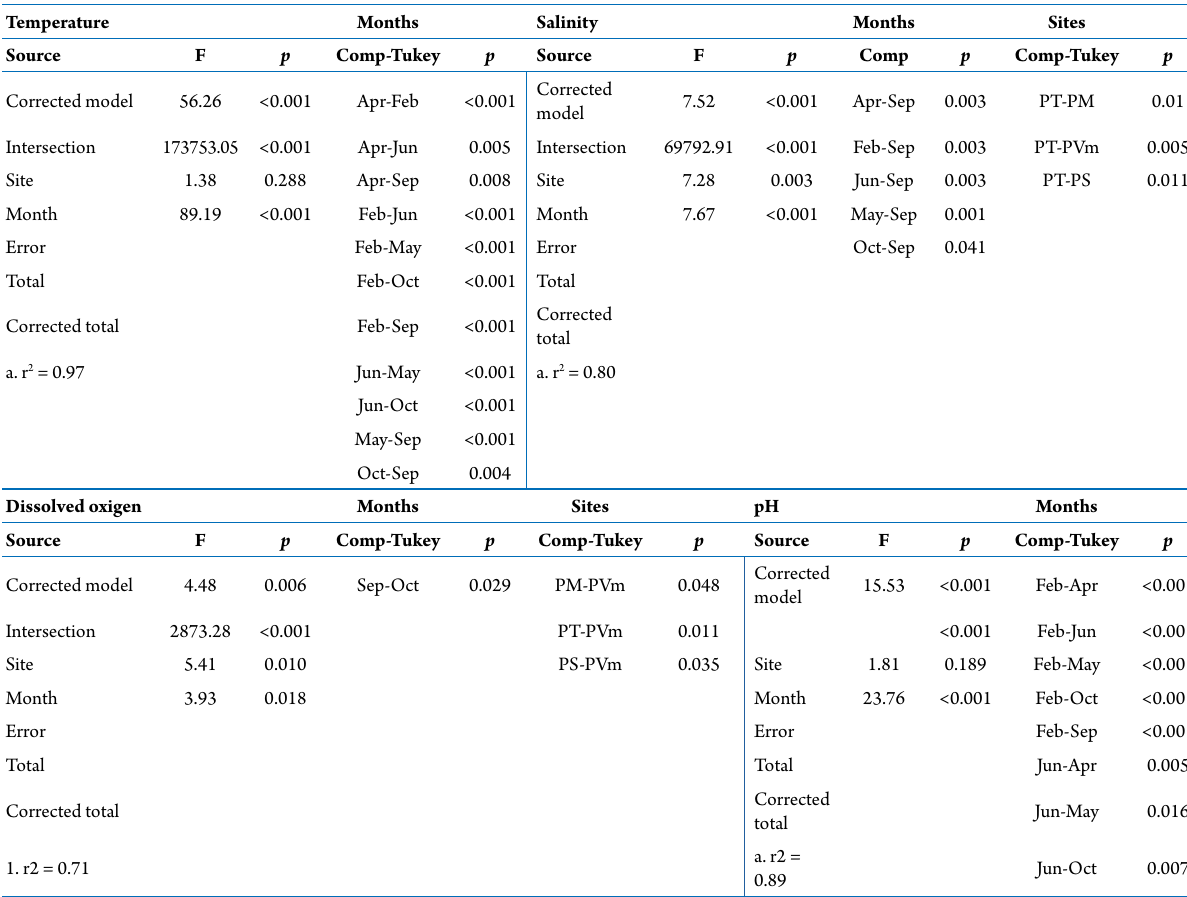
Table 2. Results of the relationships of environmental factors with respect to the sites and months with the generalized least squares (GLS) model. Comp, comparison; PM, Playa Martí; PS, Plaza de la Soberanía; PT, Playa Tortugas; PVm, Playa Villa del Mar; r 2 , Correlation